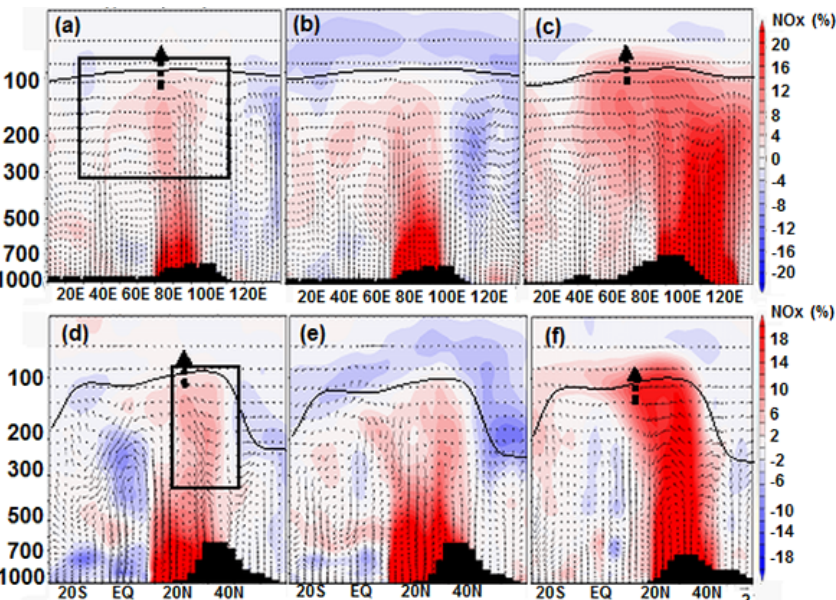
Figure 2. Longitude–pressure cross sections of percentage NO x anomalies averaged for the monsoon season (June–September) obtained from (a) Ind38 (averaged over 8–35 ◦ N), (b) Ind73 (averaged over 8–35 ◦ N), and (c) Chin73 (averaged over 20–45 ◦ N) simulations. Latitude– pressure cross sections of percentage NO x anomalies averaged for the monsoon season (June–September) obtained from (d) Ind38 (averaged over 70–90 ◦ E), (e) Ind73 (averaged over 70–90 ◦ E), and (f) Chin73 (averaged over 85–120 ◦ E) simulations. Black arrows indicate wind vectors (the vertical velocity field has been scaled by 300), the black line represents the tropopause, and the black dashed arrows indicate the cross-tropopause transport. The black boxes show the outline of the